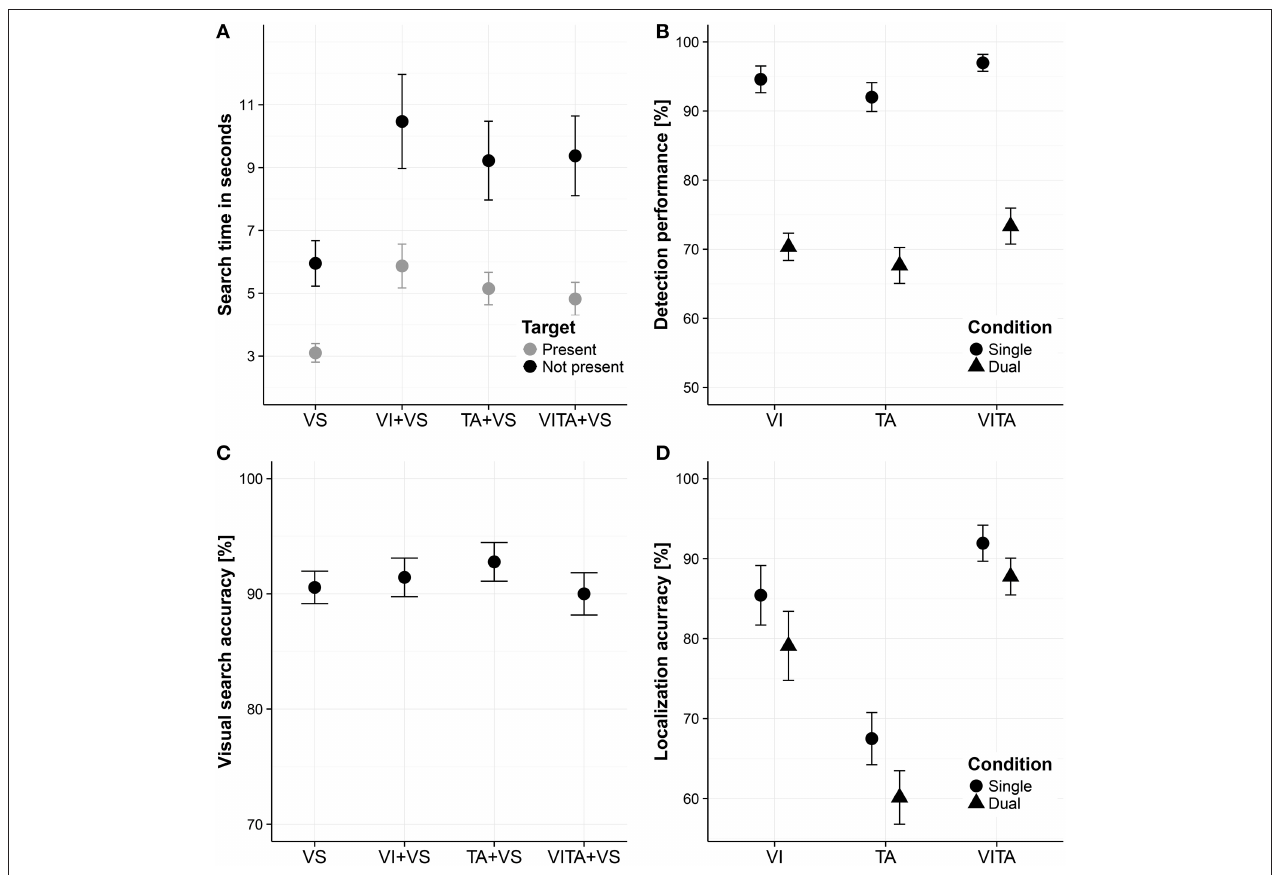
FIGURE 3 | Visual search task and localization task results. (A) Visual search times for visual search task performed alone (“VS”), performed in combination with a visual localization task (“VI + VS”), tactile localization task (“VI + TA”) or visuotactile localization task (“VITA + VS”). (B) Detection performance for localization task (i.e., fraction of spatial cues that are detected without necessarily localizing them correctly) for the visual (“VI”), tactile (“TA”) and visuotactile (“VITA”) localization task for the single and dual task condition (i.e., when the visual search task is simultaneously performed), referred to as “single” and “dual,” respectively. (C) Visual search accuracy (i.e., whether a target is present or not) for VS, VI + VS, TA + VS, and VITA + VS. (D) Localization accuracy for detected location cues (i.e., fraction correct of the detected spatial cues) for VI, TA, and VITA for the single and dual task condition, referred to as “single” and “dual,” respectively. Error bars in all panels are standard error of the